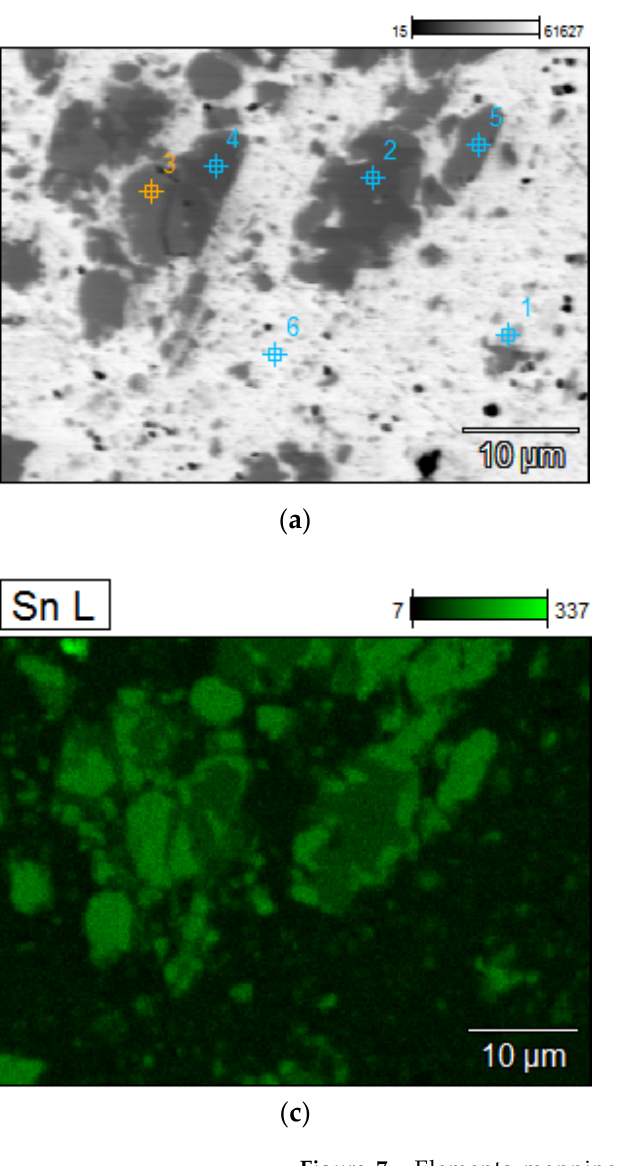
Figure 7. Elements mapping of the lead ingots after melting with PCB pyrolyzate “B1”, m PBC / m Pb = 0.1 g ∙ g − 1 . ( a ) scanning electron microscopy with a points of chemical composition; ( b – d ) copper, tin and lead located in specific areas within the alloy. Table 9. Point chemical compositions of the lead ingots after melting with PCB pyrolyzate “new”, m PBC / m Pb = 0.1 g ∙ g − 1 , points of analysis from Figure 7 .